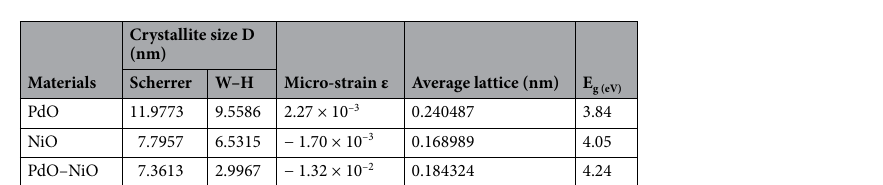
Figure 1. ( a ) X-ray diffraction pattern and ( b ) FTIR spectra of NiO, PdO and PdO–NiO ( c ) TGA curve of PdO–NiO nanocomposite.